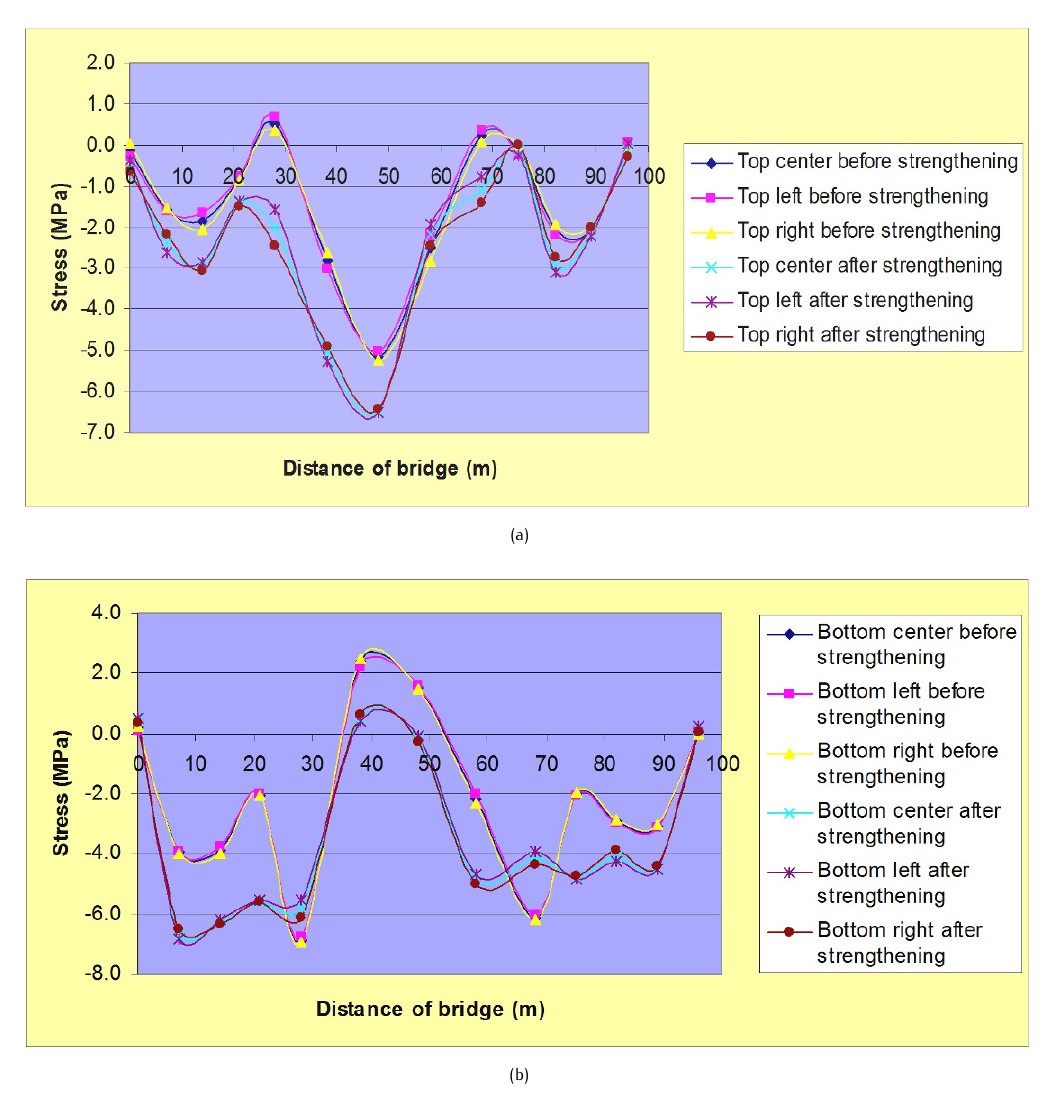
Figure 10. The values of stresses before and after strengthening due to load combination I for object No.1, (a) top of box girder, (b) bottom of box girder